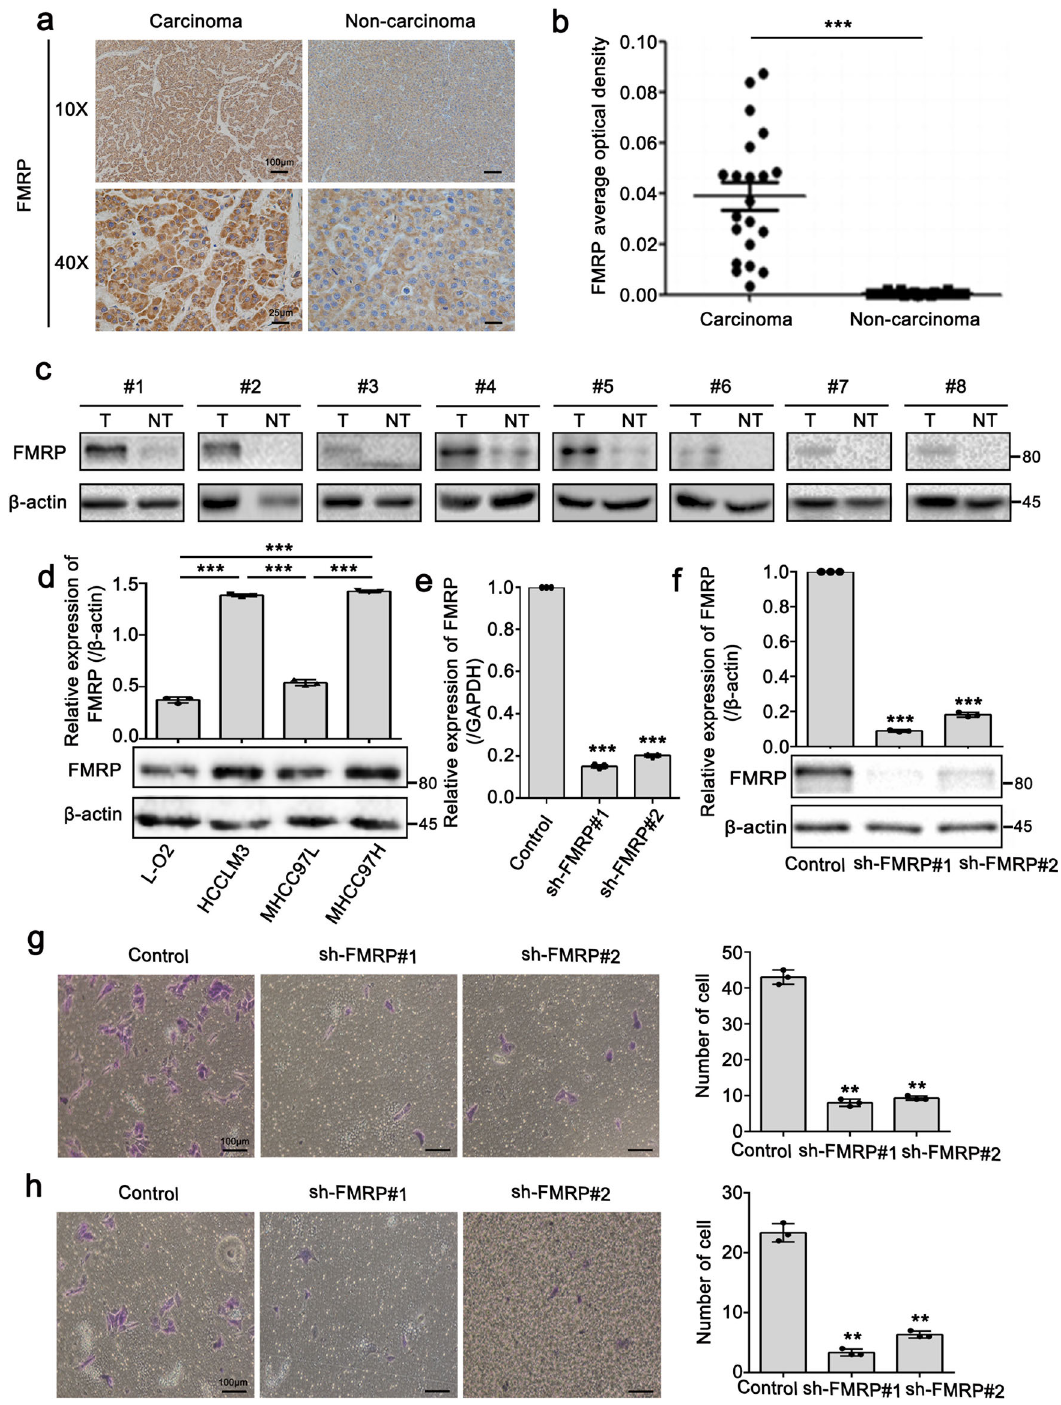
Fig. 5 FMRP knockdown suppresses the metastatic capacity of HCCLM3 in vitro. a , b Representative IHC staining ( a ) and statistics of average optical density of FMRP ( b ) in matched carcinoma tissues and non-carcinoma tissues. n = 21 biologically independent samples. Scale bar (10×): 100 μ m. c Western blot analysis of FMRP protein levels in 8 paired HCC tissues (T) and adjacent non-tumor tissues (NT). d Western blot analysis of FMRP in L-O2, HCCLM3, MHCC97L, and MHCC97H cells (lower panel) and quanti fi cation of the intensity relative to β -actin (upper panel). e , f Q-PCR ( e ) and western blot ( f ) analyses examined the knockdown ef fi ciency of FMRP in FMRP-knockdown cells. g , h Transwell migration ( g ) and invasion assays ( h ) in Control and FMRP-knockdown cells. The right panel is the quanti fi cation of the left panel. Scale bar: 100 μ m. The values in the graphs represent the mean of three biologically independent experiments. Error bars represent ±s.d. * P < 0.05, ** P < 0.01, *** P < 0.001 by two-tailed Student ’ s t-